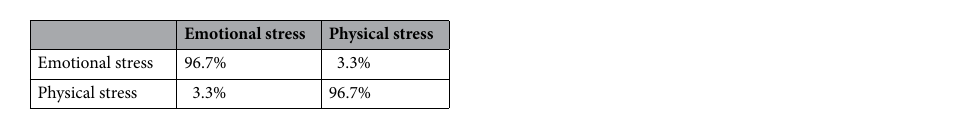
Table 1. Confusion matrix of the SC-NET algorithm for final classification result.